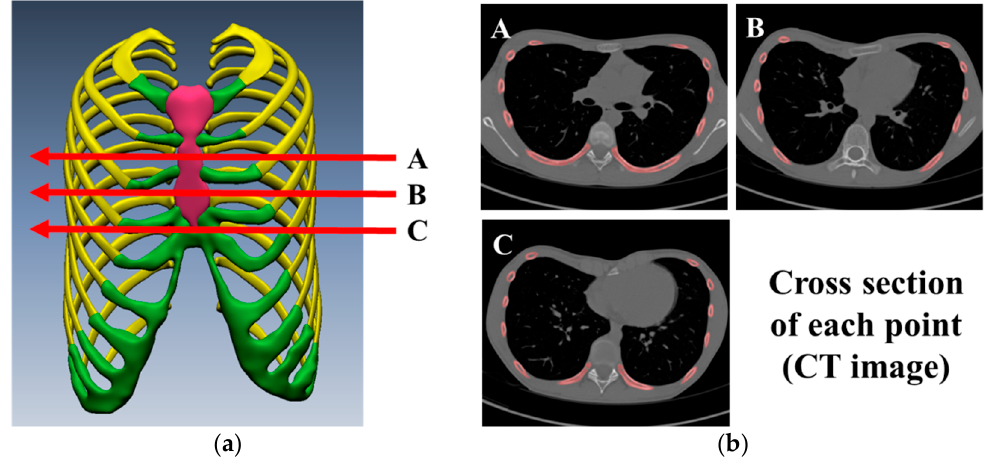
Figure 4. Virtual surgery scenario for insertion point and shape design of Nuss bar: ( a ) Nuss bar is inserted at A, B, and C points from 3D chest wall model; ( b ) CT axial images with insertion points A, B, and C.